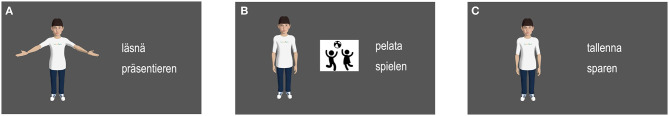
Examples for stimulus presentation in the three experimental conditions: (A) Gesture-based enrichment for “to present” (Fin.-Ger.: läsnä—präsentieren); (B) picture-based enrichment for “to play” (Fin.-Ger.: peleta—spielen); (C) no enrichment for to scrape (Fin.-Ger.: tellenna—sparen).